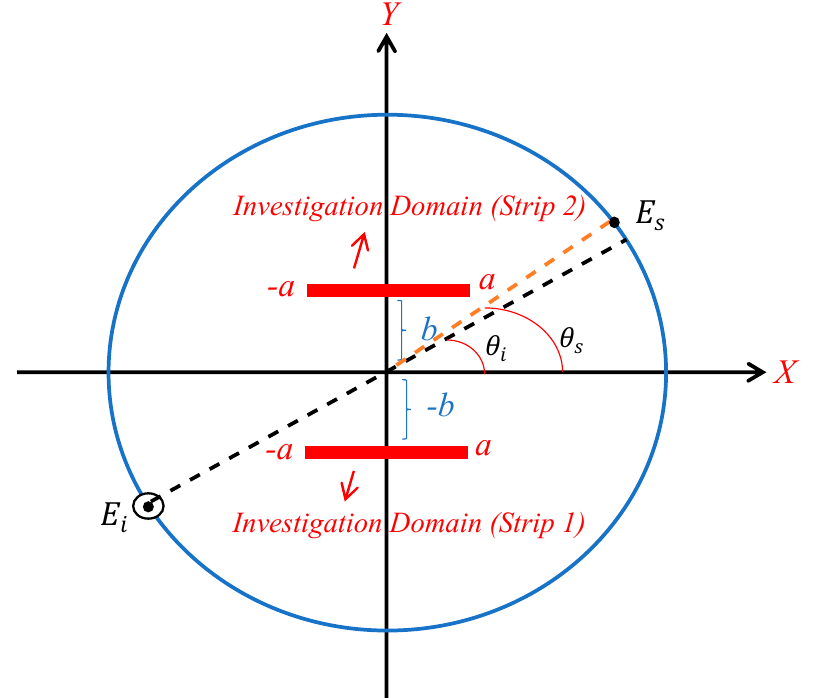
Figure 6. The geometry of the two strips ID .